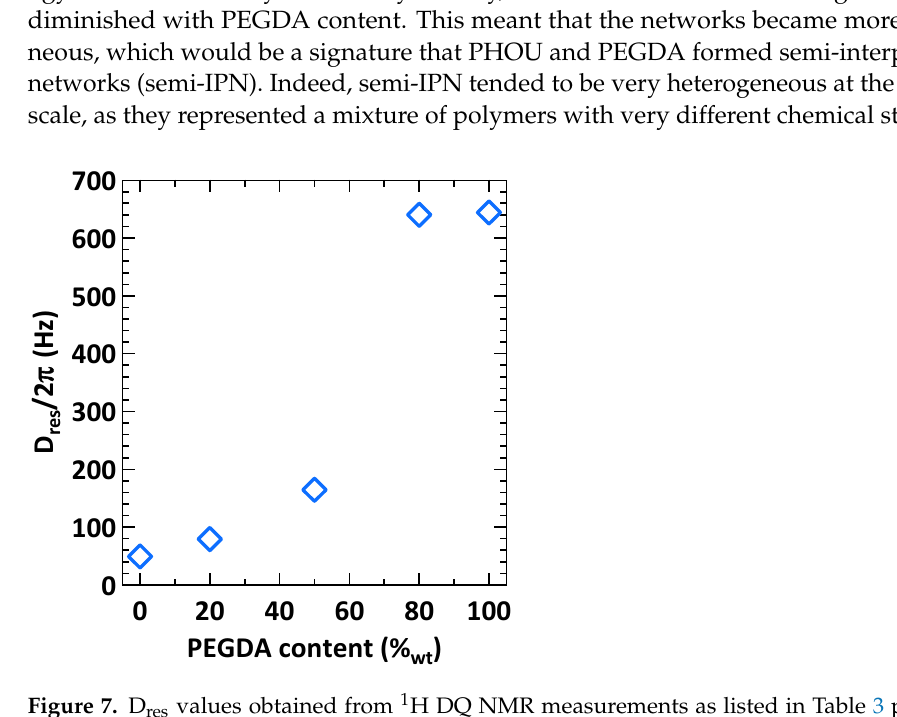
Table 4. G ′ and G ″ values of networks at 10 Hz. Samples